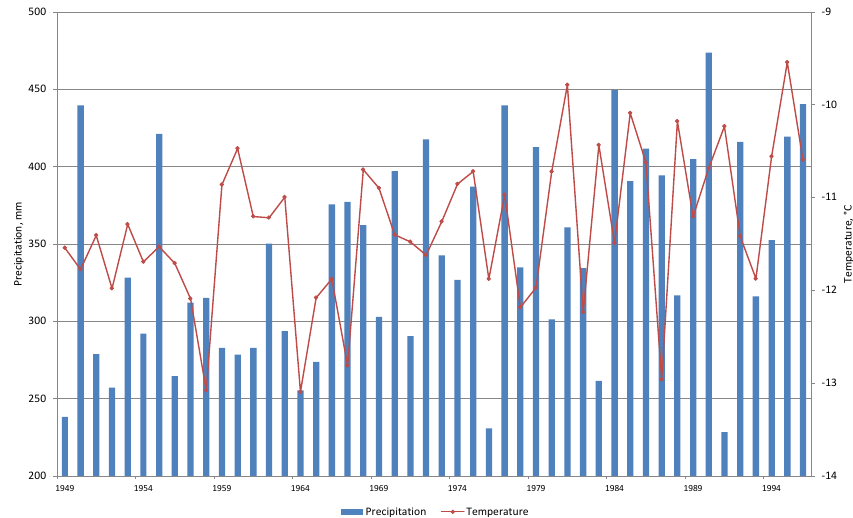
Figure 9. Annual precipitation (mm) and air temperature ( ◦ C) at Nizhnyaya weather station, 1949–1996.